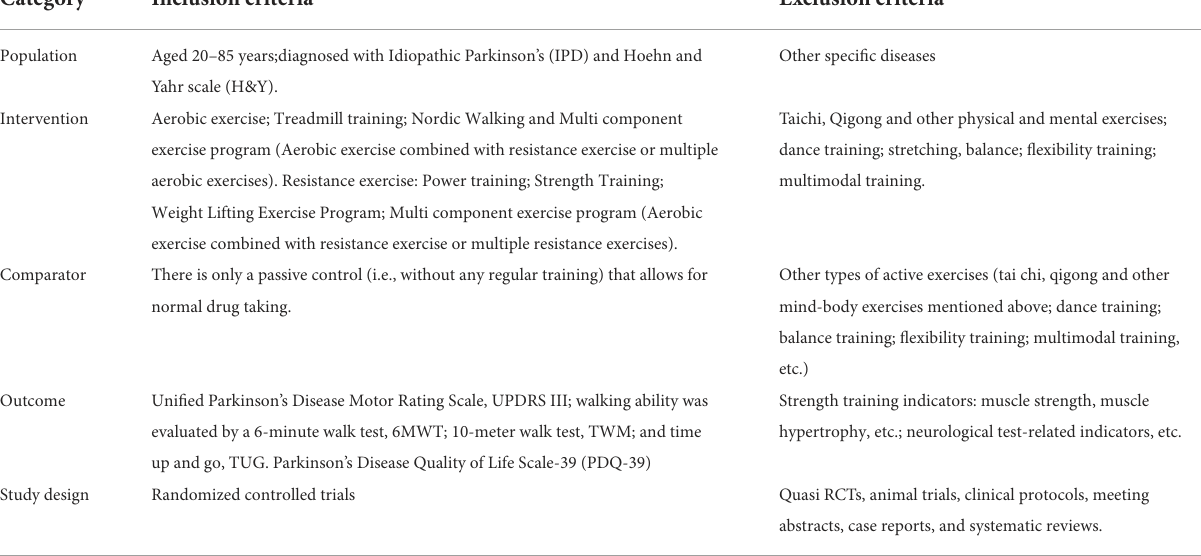
TABLE 1 Selection